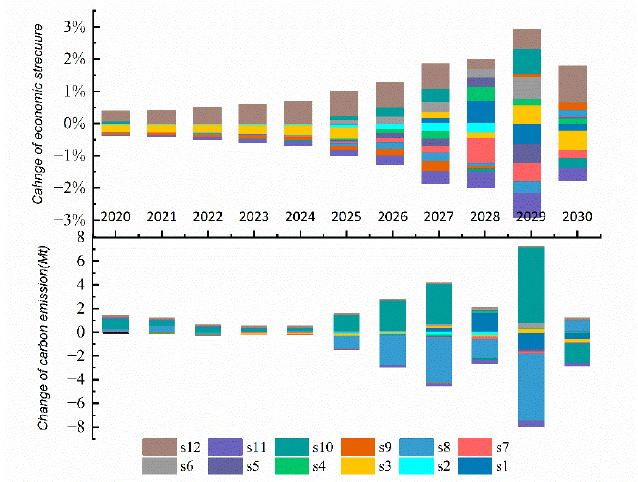
Figure A3. The structural change of the industrial added value and carbon emissions.